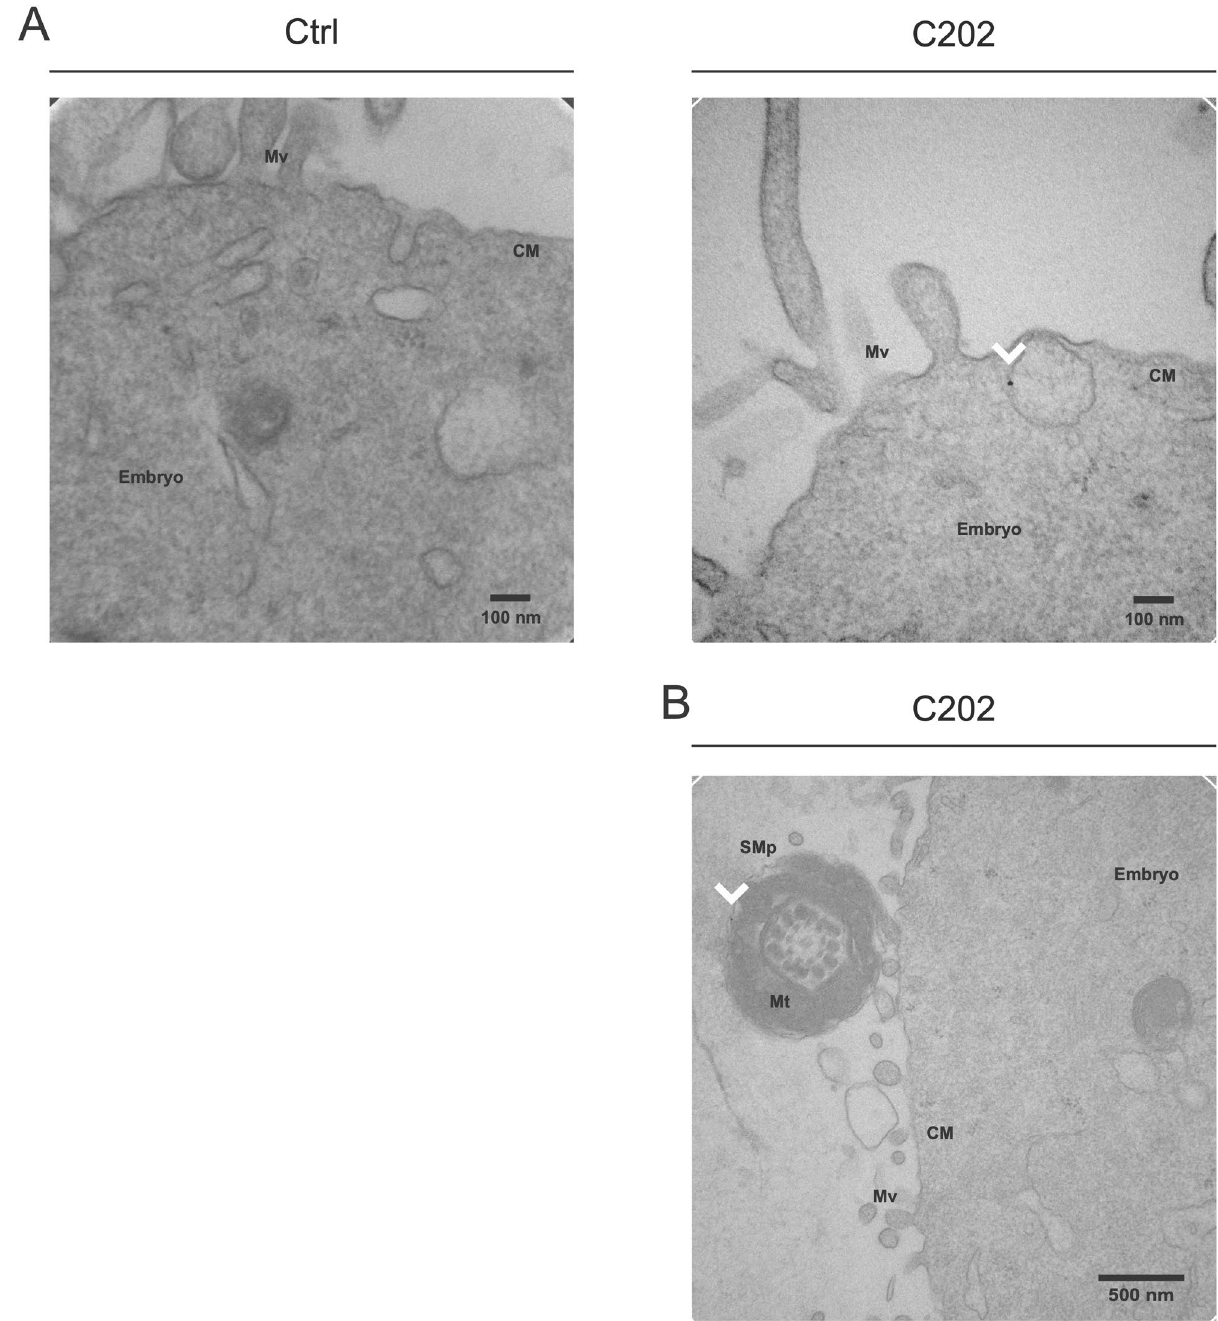
Figure 5. CD63-HA facilitates visualizing evidence of the transfer of DC2 epididymal epithelial cell EV cargo to fertilized embryos. ( A ) Immunogold transmission electron microscopy (IEM) confirmed anti-HA staining in 1-cell embryos generated by IVF using sperm previously incubated with CD63-HA EVs (C202), but not Control (Ctrl), at single epitope resolution (white arrow heads). ( B ) IEM also captured anti-HA staining on a sperm midpiece (SMp) found adjacent to an embryo, supporting continuous detection of EV cargo following sperm-mediated EV transfer at fertilization. CM: cell membrane, Mt: mitochondria, Mv: microvilli, SMp: sperm with 0.35 mg/mL Geneticin sulfate (Gibco, 10131035) for 8 weeks. Polyclonal transfected cells were then plated at low density, such that following several rounds of replication, isolated clonal colonies of cells could be identified visually, overlayed with agarose, and picked for expansion (Lindberg Lab online protocol, http:// theli ndber glab. com/ cloni ng- cells- with- the- agaro se- method/). This process of transfection followed by selection of clonal cell lines was repeated sequentially for transient expression plasmids encoding Flipase and Cre recombinase. PCR characterization of the CD63 loci was performed with flanking primers (5 ′ -TGG AGG TGA AGA ATG CTG TG-3 ′